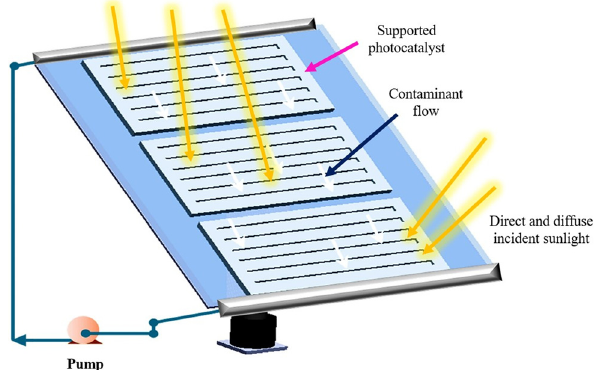
Figure 6: Planar photocatalytic reactor with non - concentrated solar energy, having laminar fl ow recirculation, with photocatalyst on plates.